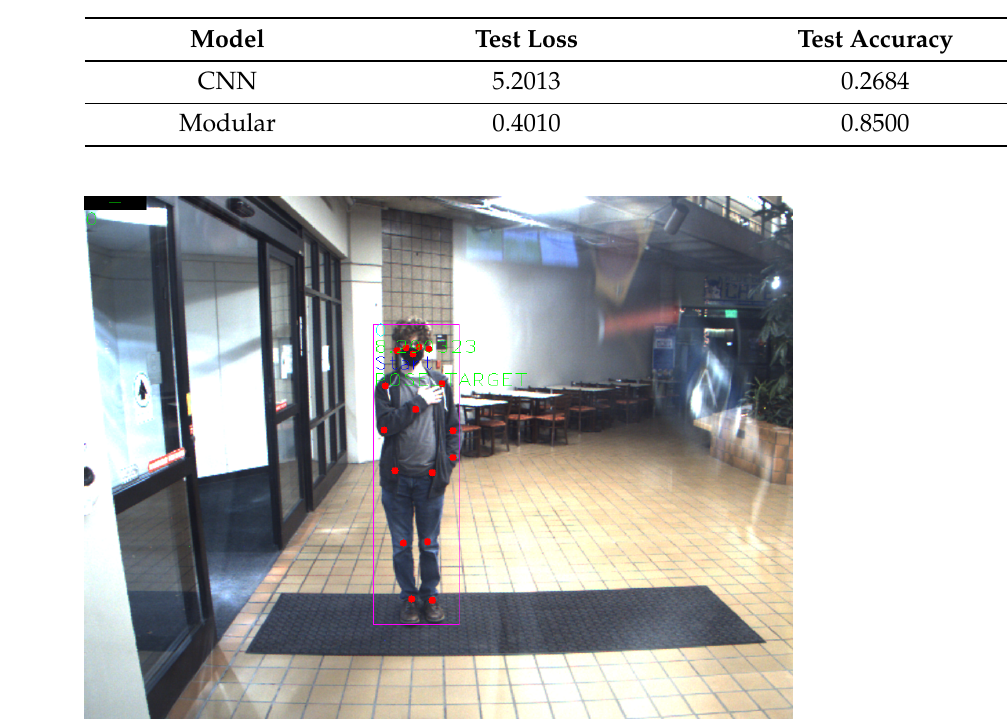
Table 2. Comparison of CNN and modular designs when evaluated on the same testing dataset. Higher accuracy values and lower loss values indicate better models.